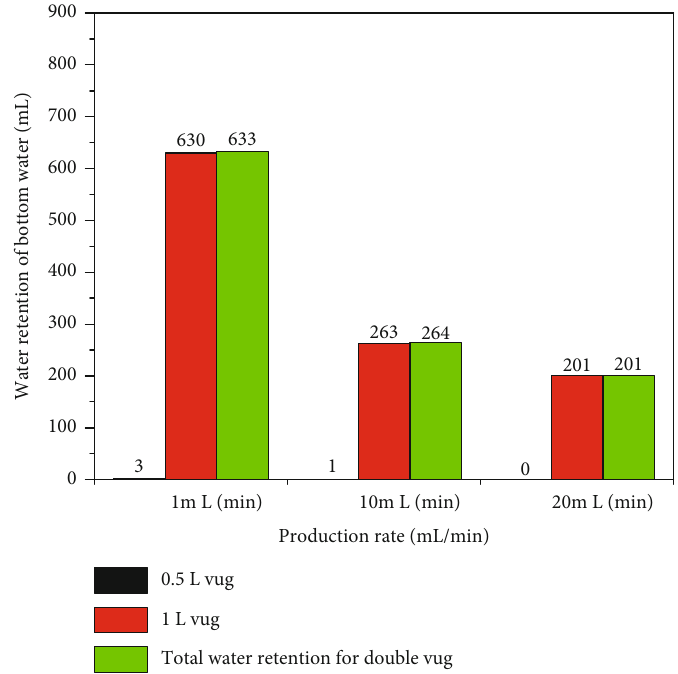
Figure 17: Column chart of bottom water invasion and retention in high-pressure physical property experiments under connection type I (di ff erent production